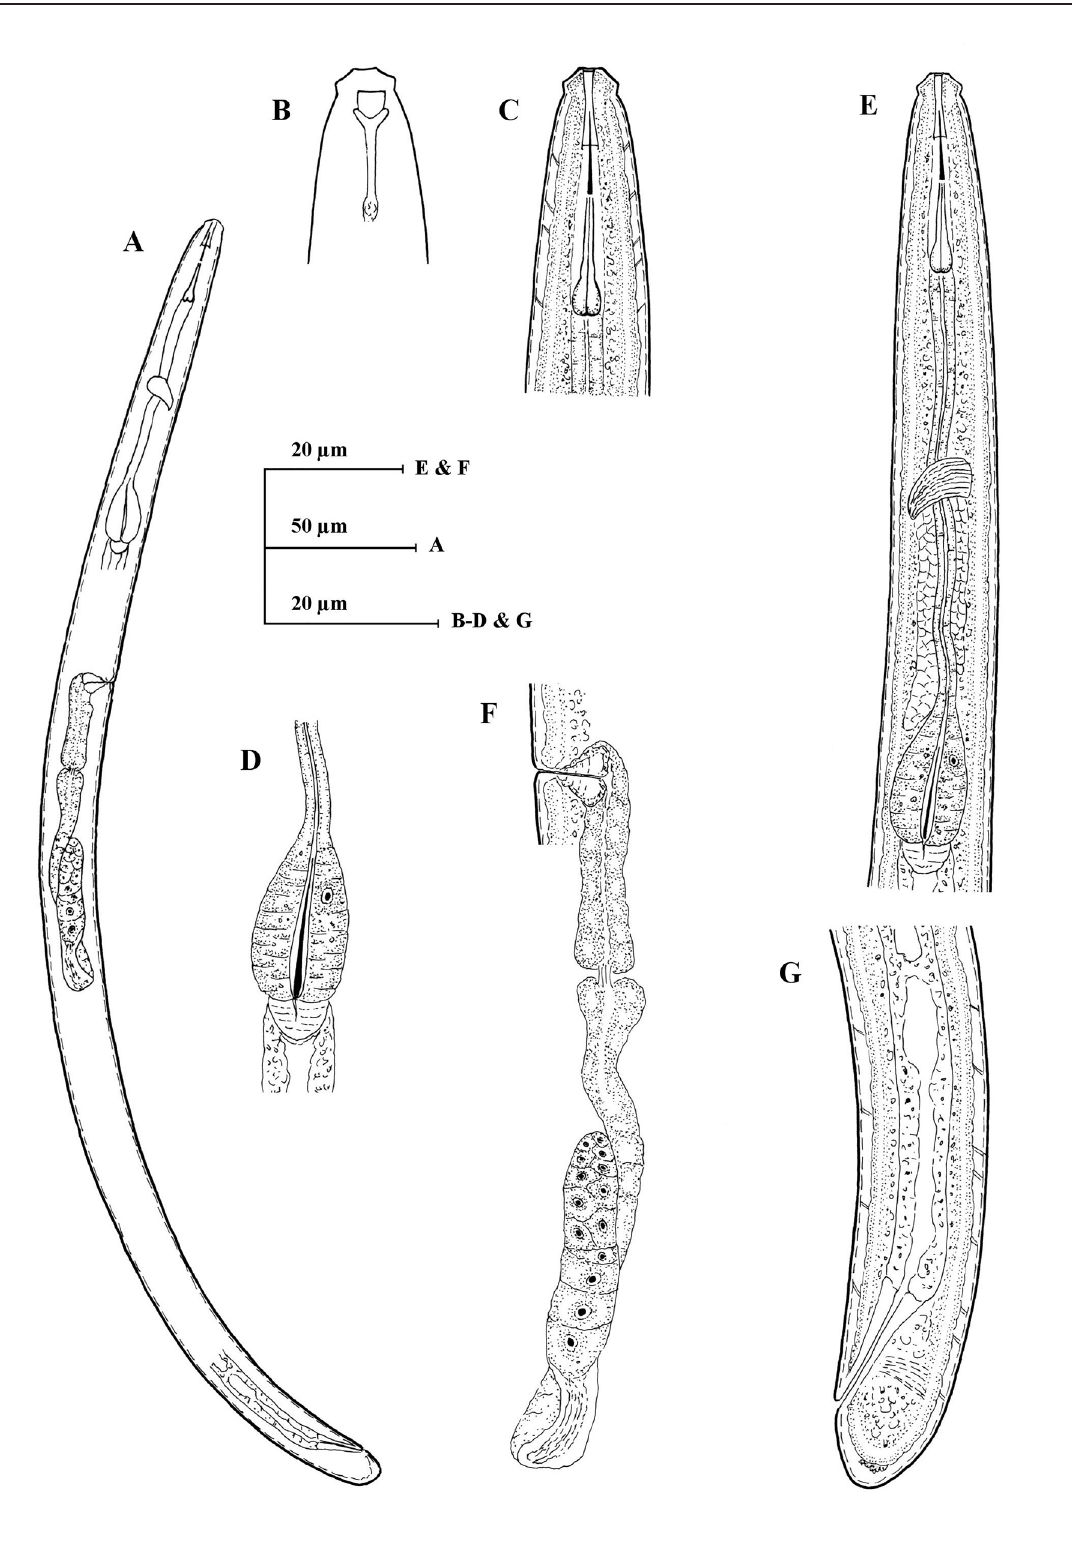
Fig. 6. Basirotyleptus minutus Khan, 1987, ♀ (AMU/ZD/NC/ Basirotyleptus minutus /1). A . Entire specimen. B . Anterior region showing amphid. C . Anterior region. D . Pharyngeal bulb. E . Pharyngeal region. F . Genital system. G . Posterior